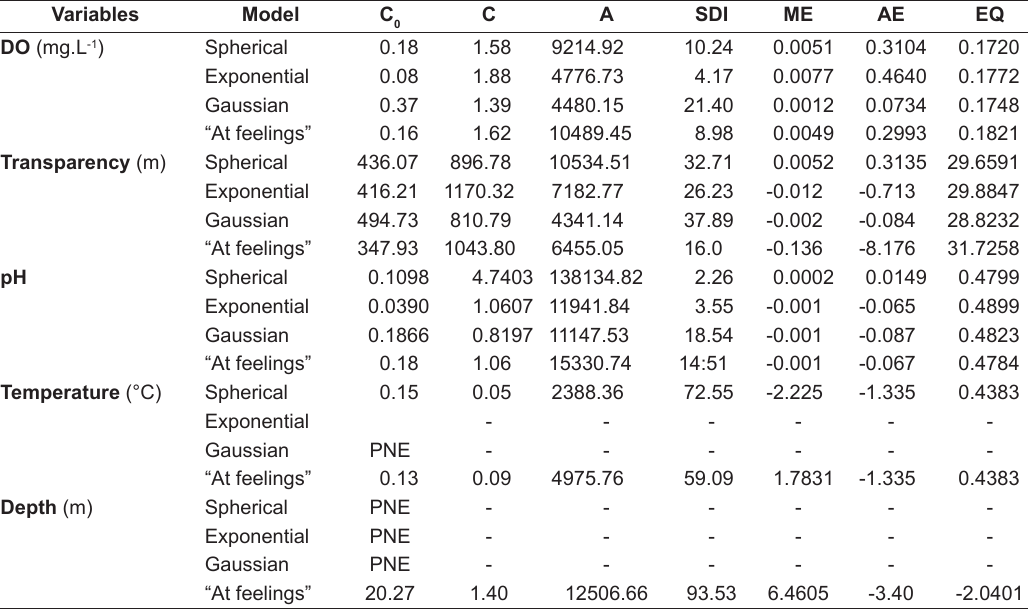
DO = Dissolved Oxygen; pH = Hydrogenionic Potential; CV = Coefficient of Variation. Table 2. Results of the geostatistical analysis of the physical-chemical parameters of the water sampled in the reservoir of the Curuá-Una HPP, Brazil, in November